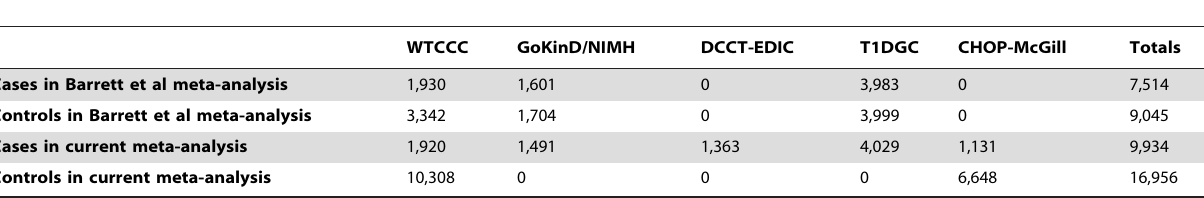
Table 3. A comparison of the number of samples used in each discovery cohort from the current meta-analysis and those used in the previously reported meta-analysis [29]